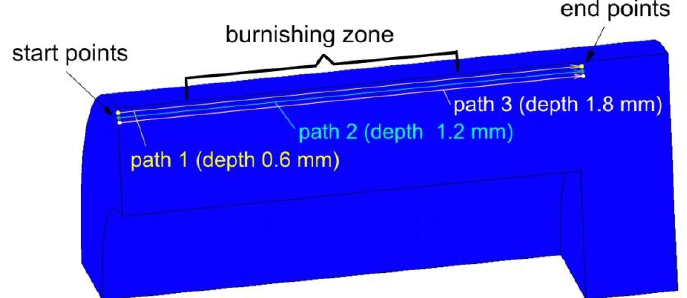
Figure 20. Scheme for measuring the distribution of equivalent plastic strains in numerical model.